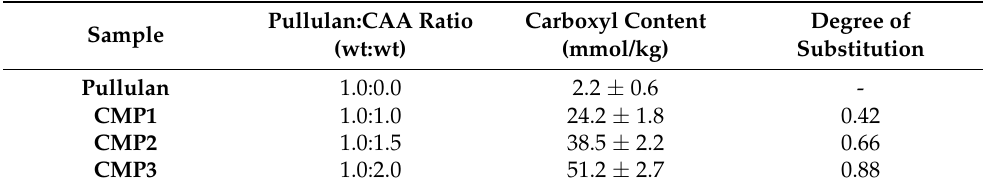
Table 1. Content of carboxylic group in pullulan after